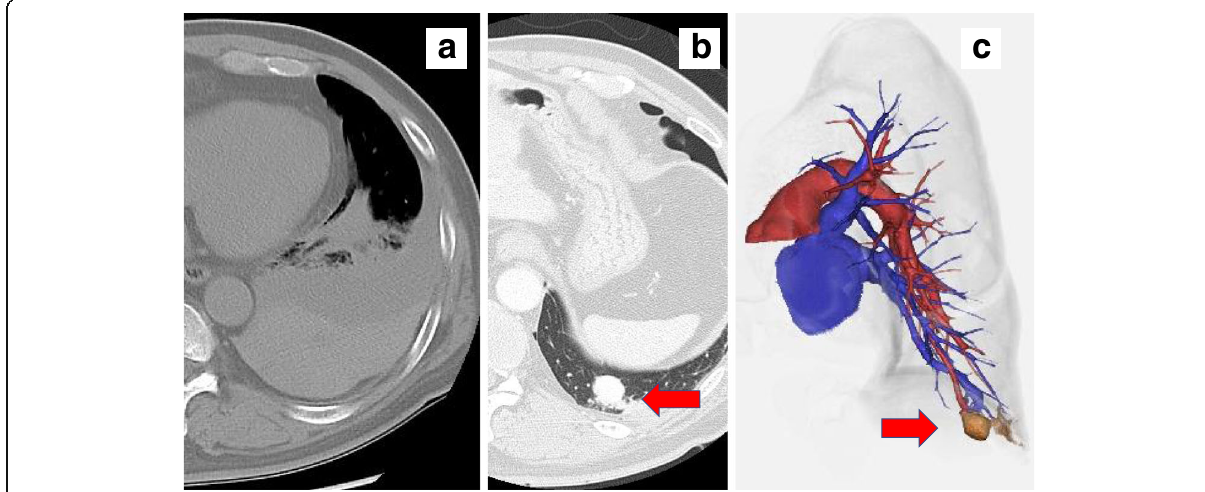
Fig. 1 Chest computed tomography findings. a Chest CT showing left-sided hemothorax. b Chest CT after drainage showing a solitary nodule in the left lower lobe. c Three-dimensional CT showing the nodule to be suggestive of a